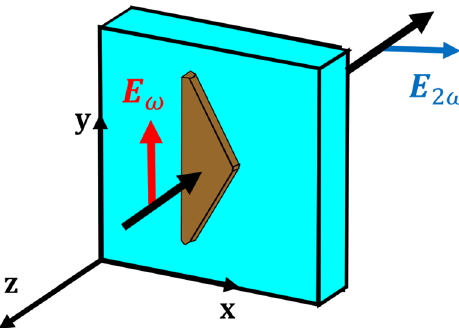
Fig. 1. Schematic con fi guration for SHG emission considered in this paper. Fundamental light with y -polarization is normally incident on the metasurface. Transmitted SHG with x -polarized is observed.